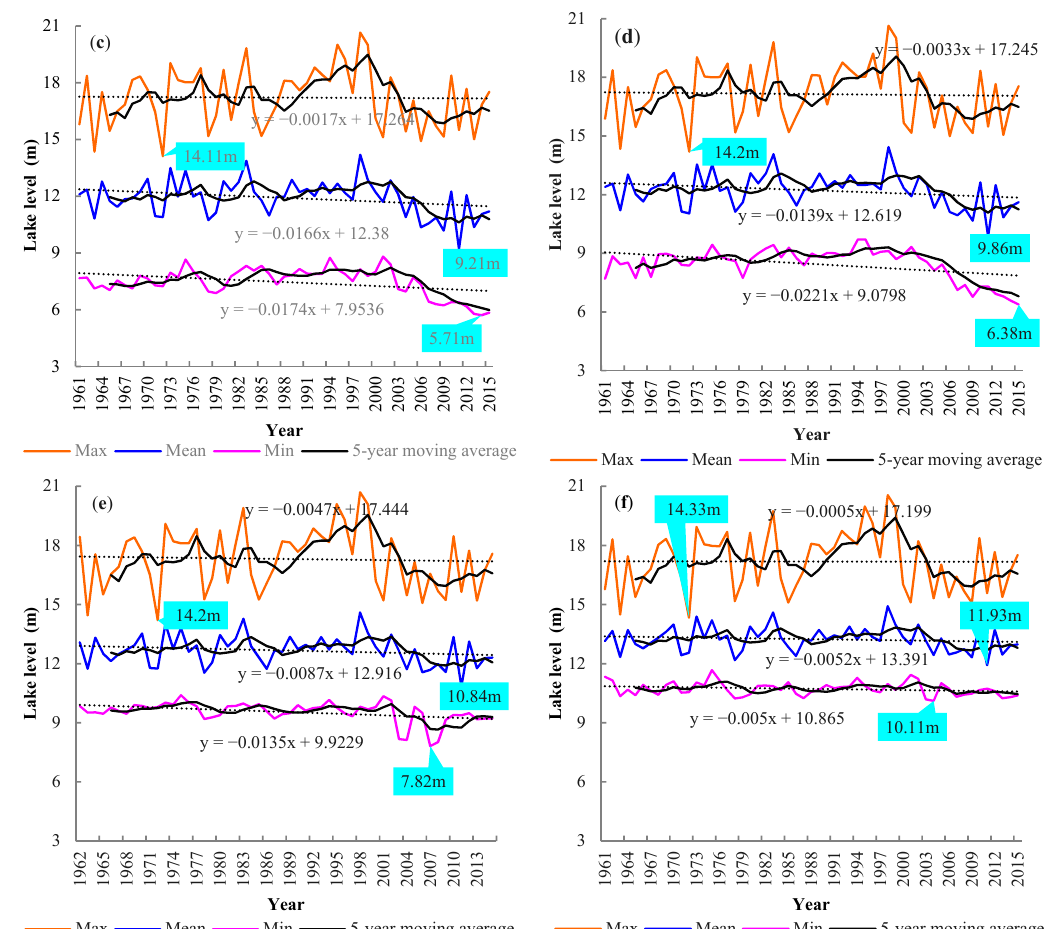
Figure 5. Hydrographs of maximum, minimum, and mean lake level at six gauging stations in the Poyang Lake: ( a ) Hukou; ( b ) Xingzi; ( c ) Duchang; ( d ) Wucheng; ( e ) Tangyin; and ( f ) Kangshan.